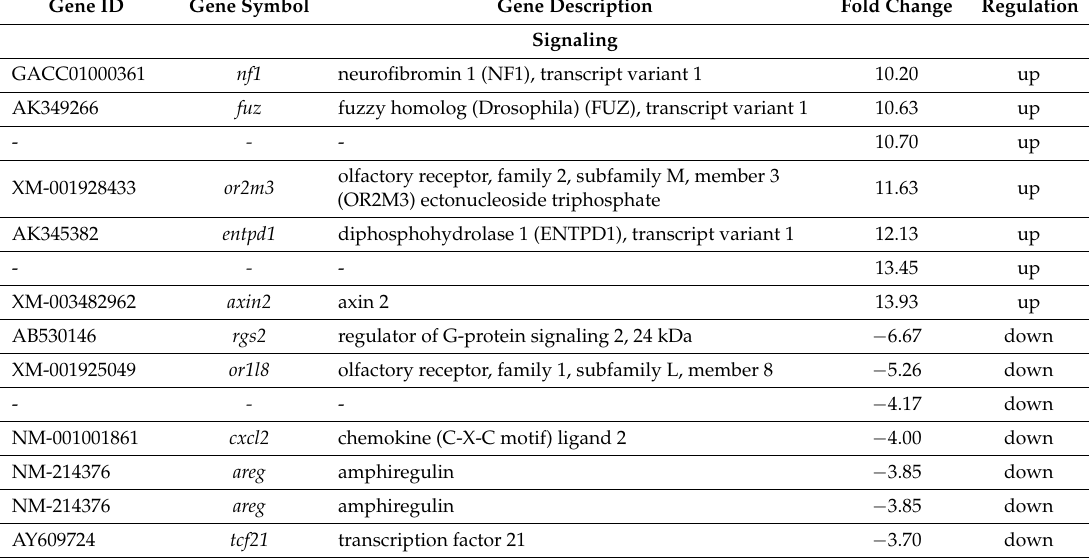
Table 2. List of the most strongly upregulated or downregulated genes involved in signaling in IPEC-cells.